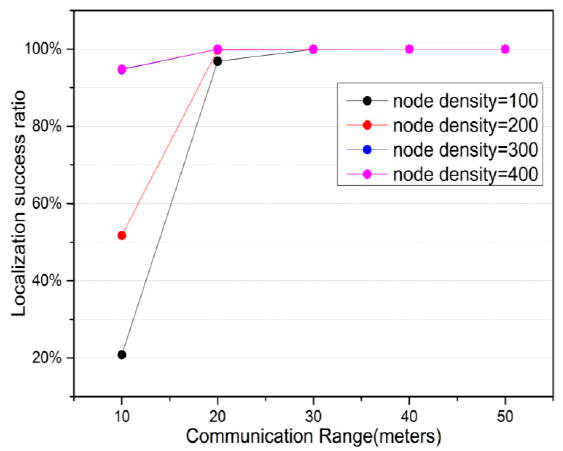
Figure 7. The effect of communication range on localization success ratio.